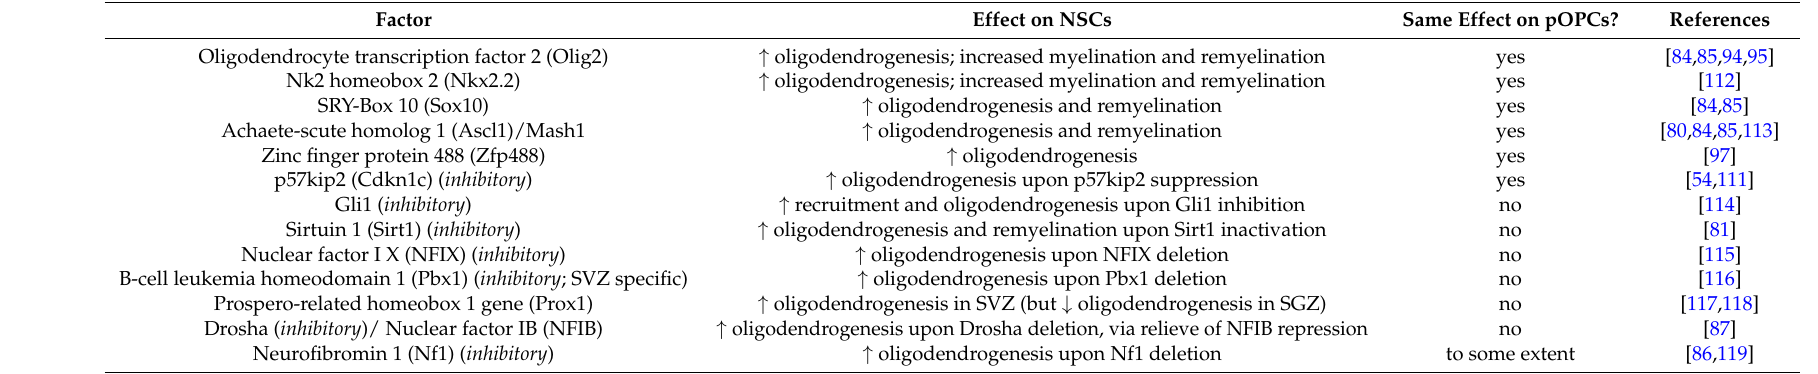
Table 1. Summary of intrinsic factors and their oligodendrogenic effects on NSCs and pOPCs.